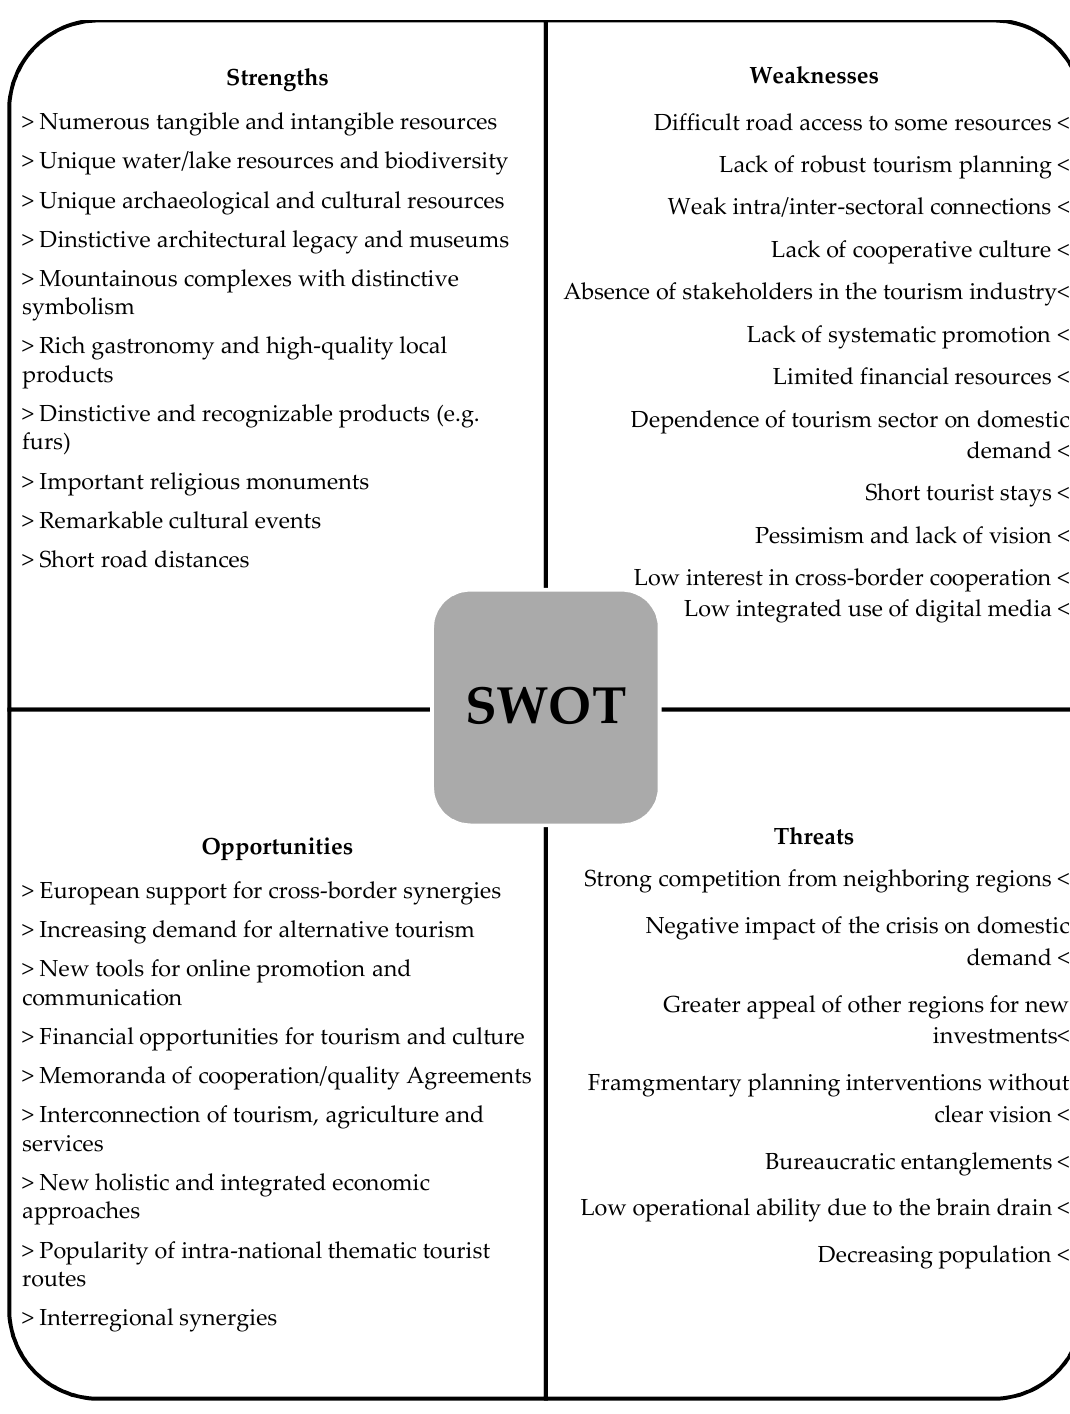
Figure 1. SWOT analysis of the Greek–Albanian cross-border area regarding eco-cultural resources [54].